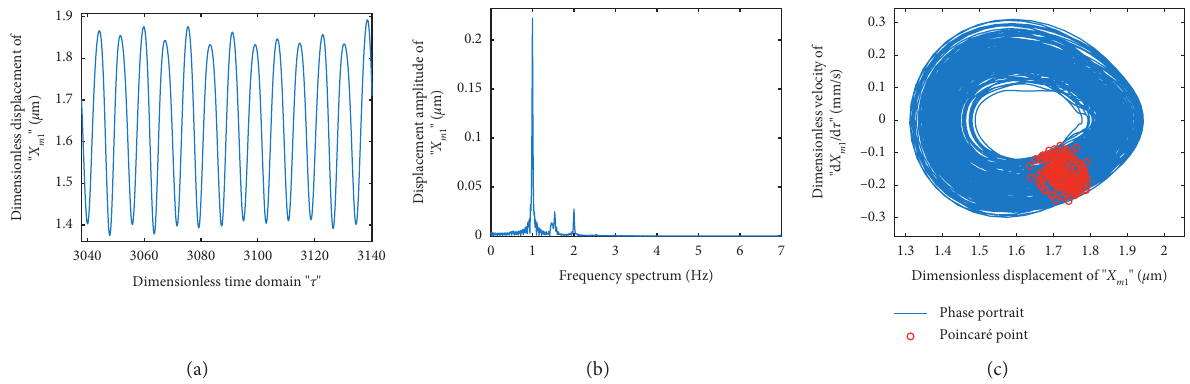
Figure 6: The dynamic response of system X